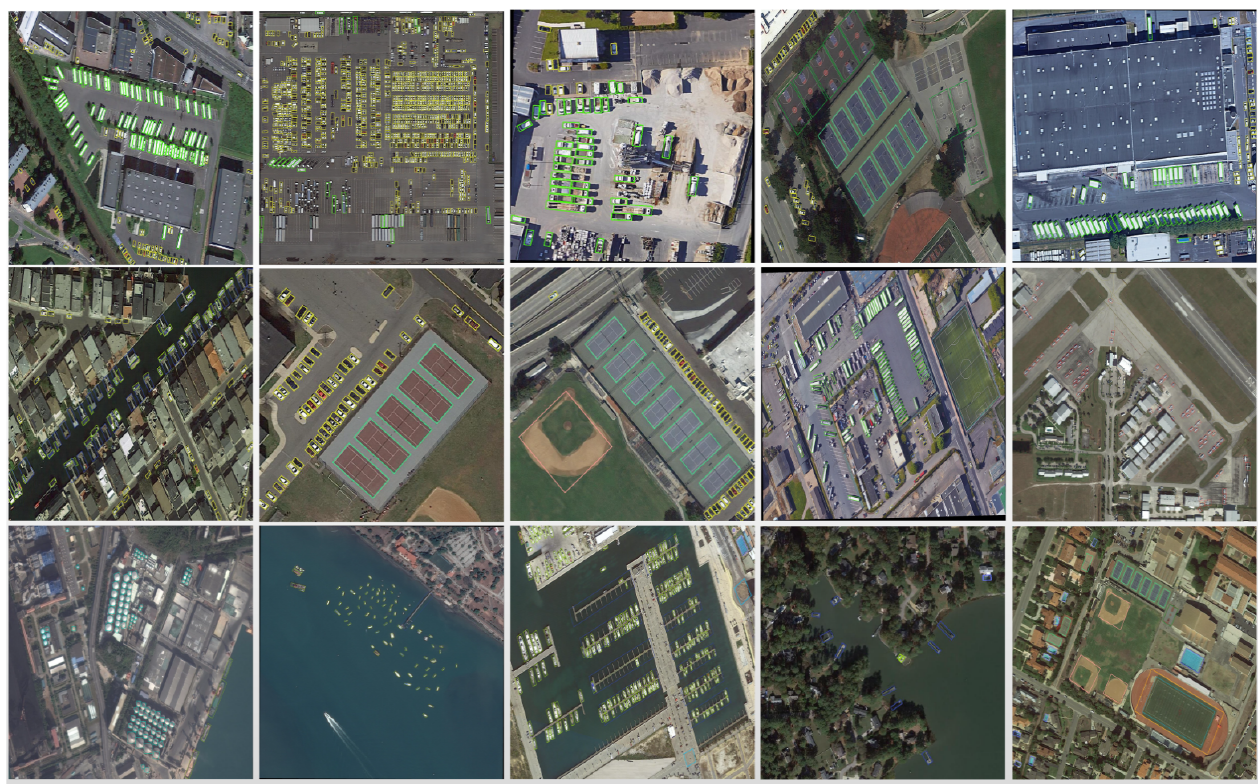
Figure 10. Visualization results of DOTA image detection.